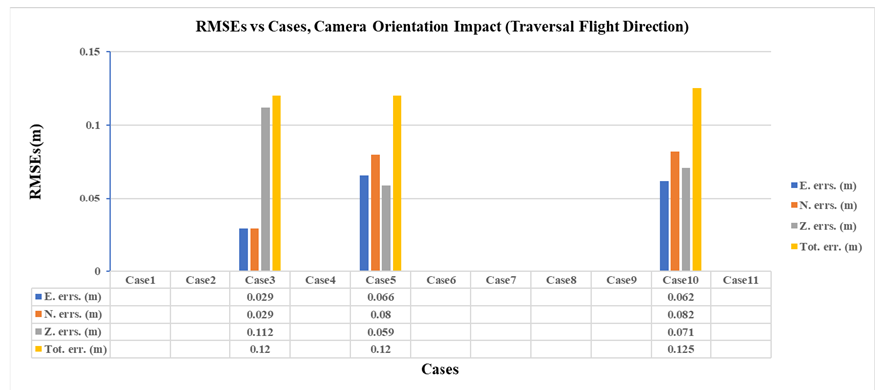
Figure 12. The impact of camera orientation (traversal flight direction).